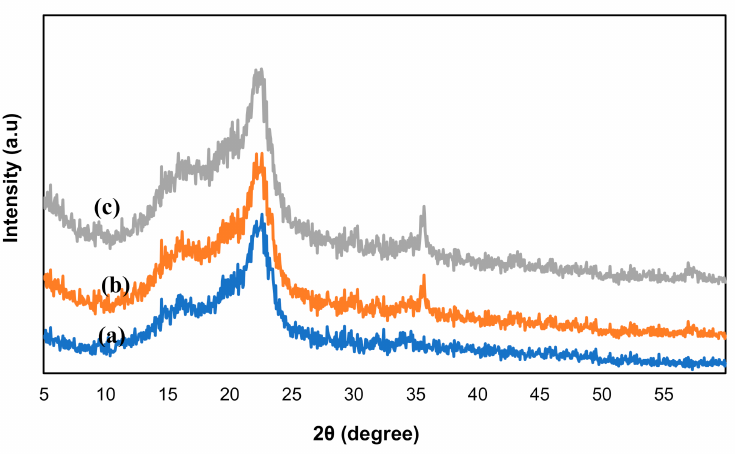
Figure 7. X-ray diffraction analyses for ( a ) CNF, ( b ) Fe 3 O 4 and ( c )